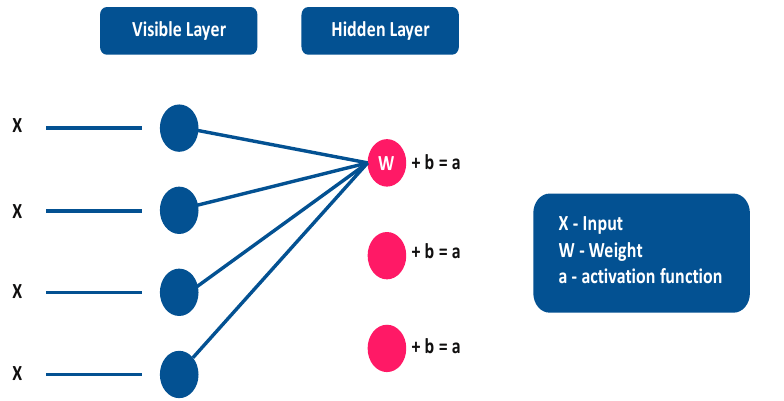
Figure 11. A representation of weighted inputs combined at hidden node in RBM [53]. In each hidden node, each input x is multiplied by its corresponding weight w. This means that a single input x will have three weights, making a total of 12 weights (four input nodes and three hidden nodes). The weights between the two layers will always create a matrix in which the rows correspond to the inputs and the columns correspond to the outputs. The four inputs are multiplied by their respective weights for each hidden node. After adding this sum to a bias (which forces some activations to occur), the result is passed through an activation algorithm to produce the output of the node as shown in Figure 12.